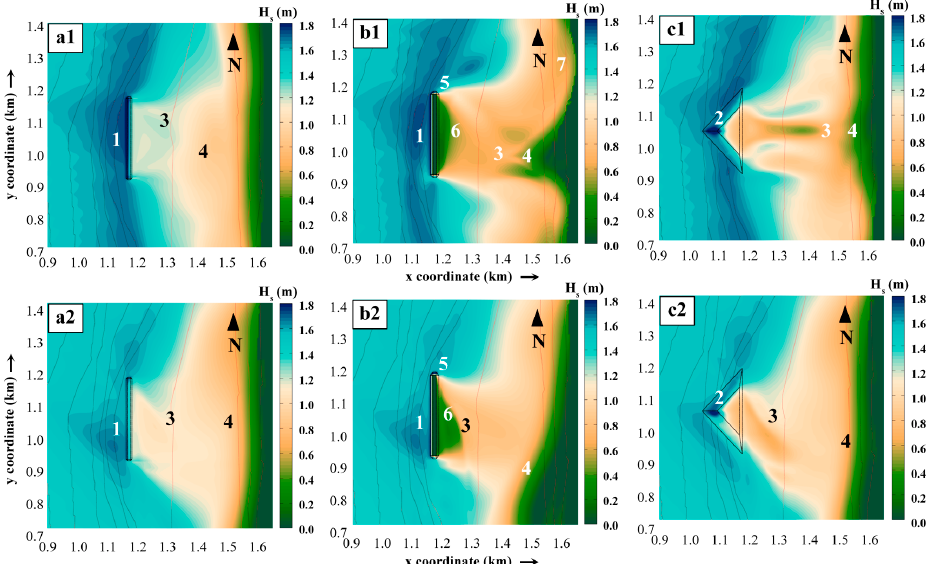
Figure 6. Significant wave height dissipation for frequent wave condition (XBeach model) for the west wave direction (upper panel): submerged detached breakwater ( a1 ), emerged detached breakwater ( b1 ), and MFAR ( c1 ); and for the northwest wave direction (lower panel): submerged detached breakwater ( a2 ), emerged detached breakwater ( b2 ), and MFAR ( c2 ). The indicated numbers